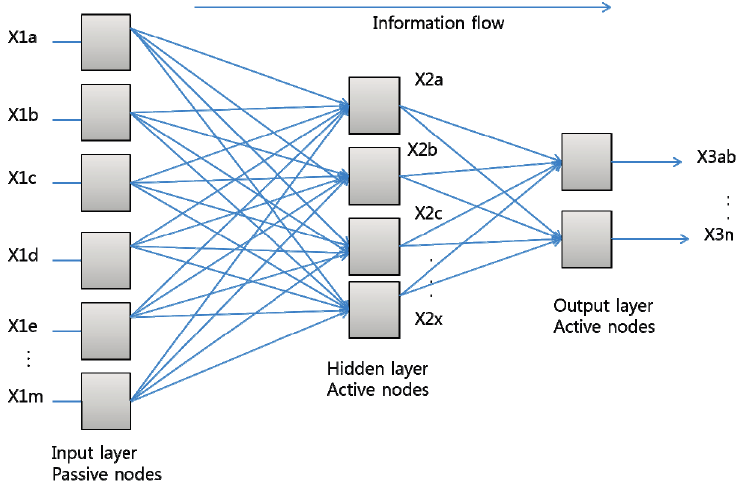
Figure 9. Multilayered artificial neural